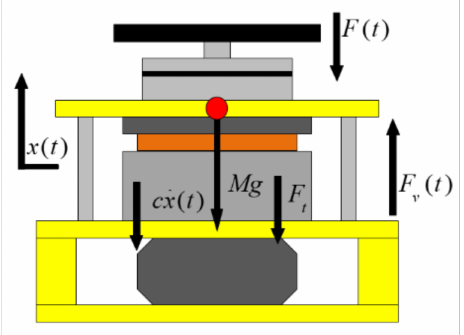
Figure 3. Free body diagram of the grinding